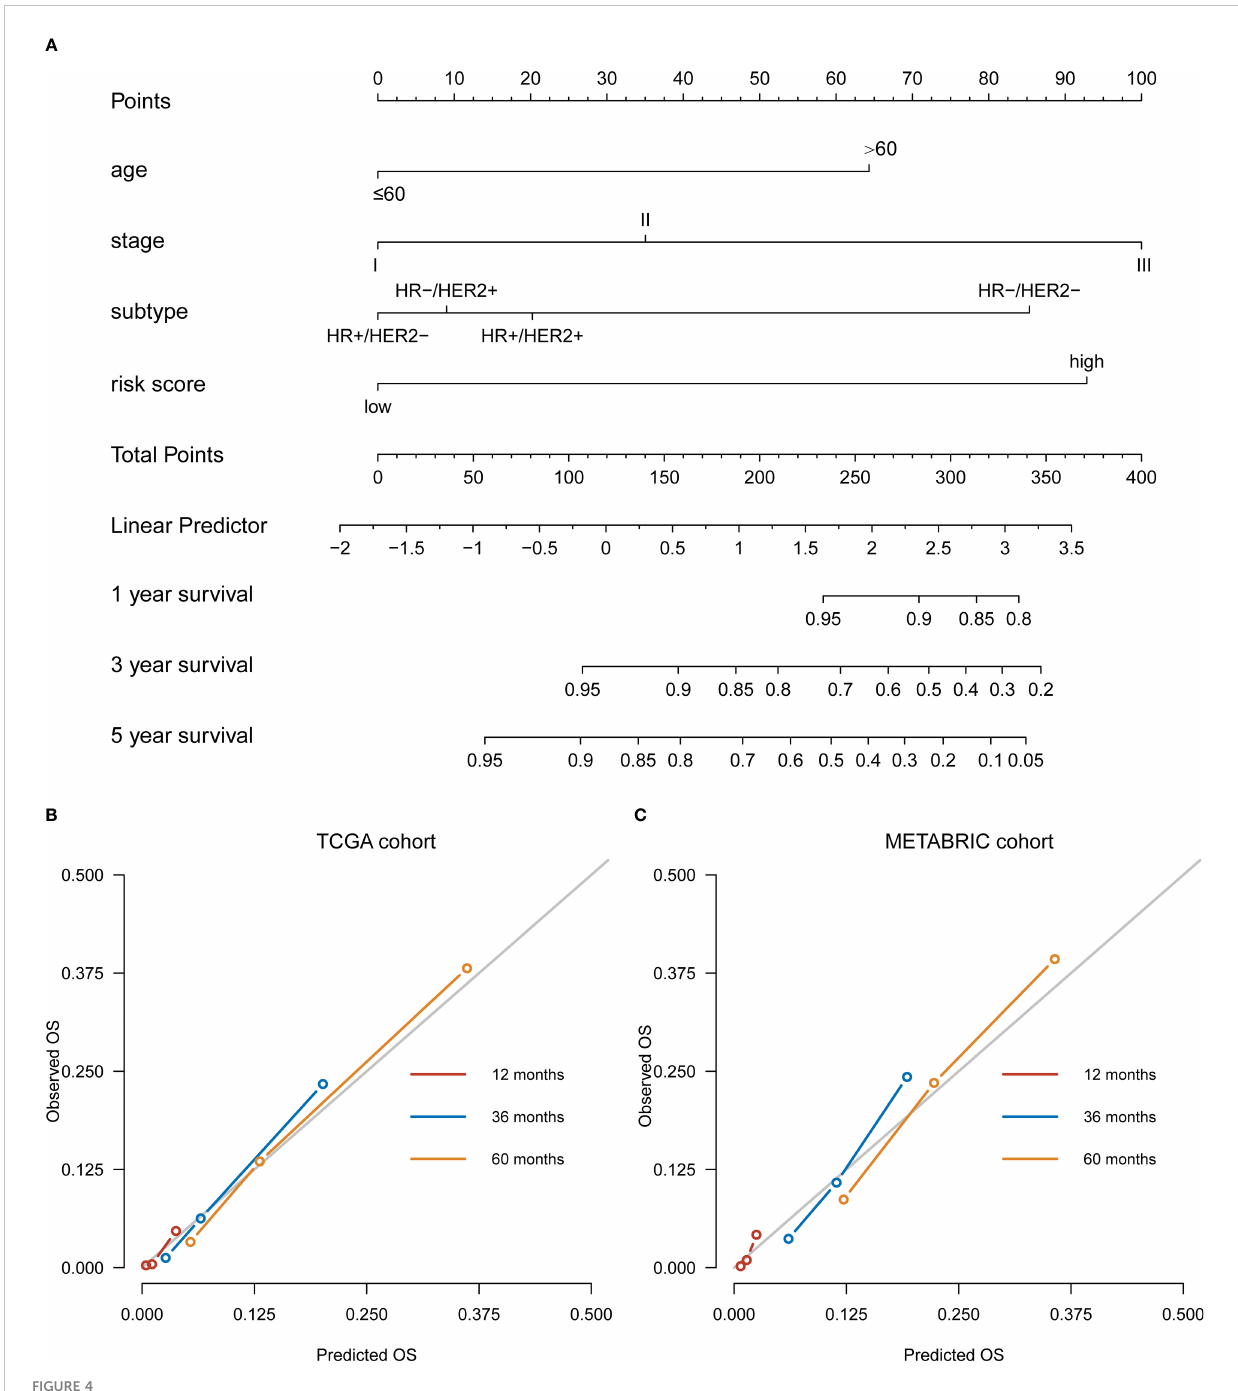
FIGURE 4 Development of a nomogram based on ovarian ageing-related genes (OARGs) signature for predicting overall survival (OS) of patients with breast cancer. (A) The nomogram plot integrating OARG risk score, age, stage and subtype in the TCGA training cohort. (B) The calibration plot for the probability of 1-, 3-, and 5-year OS in the TCGA training cohort. (C) The calibration plot for the probability of 1-, 3-, and 5-year OS in the METABRIC validation